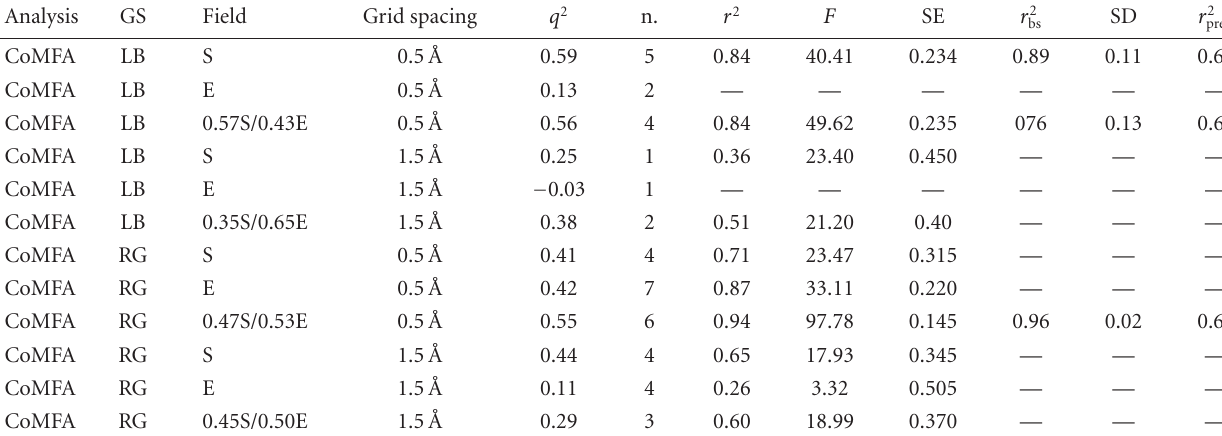
Table 3: Statistics of di ff erent PLS analysis after region focusing. (GS: geometrical scheme; SE: standard error of estimate; n.: number of components; F : Fischer’s F value for test of significance; r 2 deviation; Field contribution: (S) steric field, (E) electrostatic field, (H) hydrophobic field, (D) H-bond donor field, and (A) H-bond acceptor